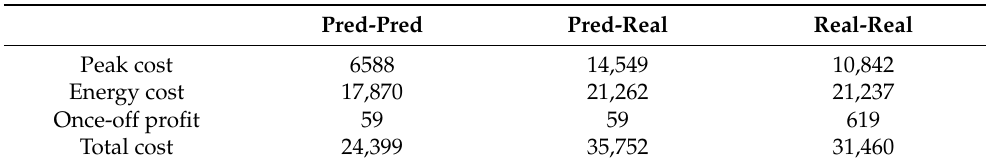
Table 5. Cost of the predicted and real load in AUD, resulting from optimizations on predicted and real load for problem instance